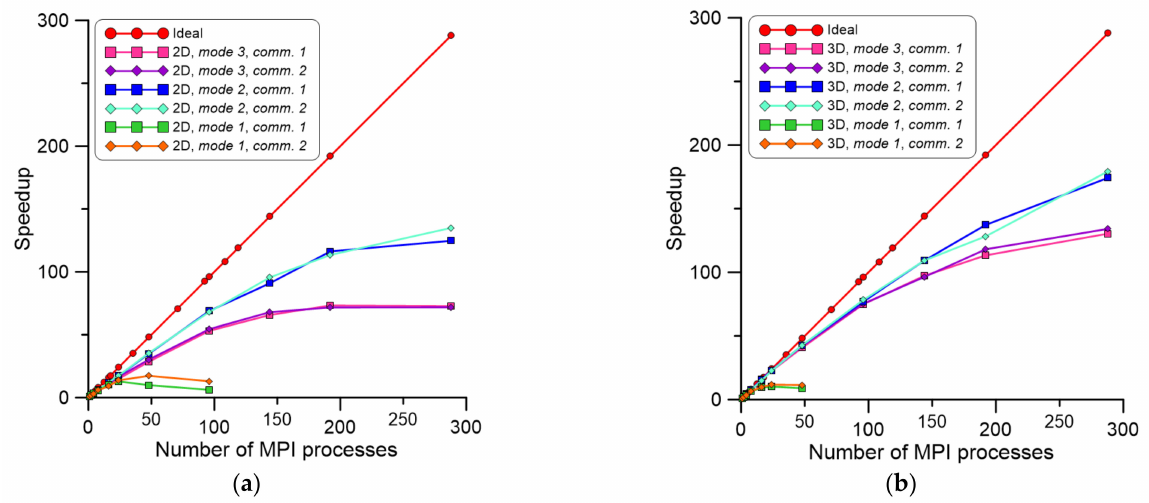
Figure 6. Speedup from ( a ) 2D and ( b ) 3D investigations for a different number of MPI processes.